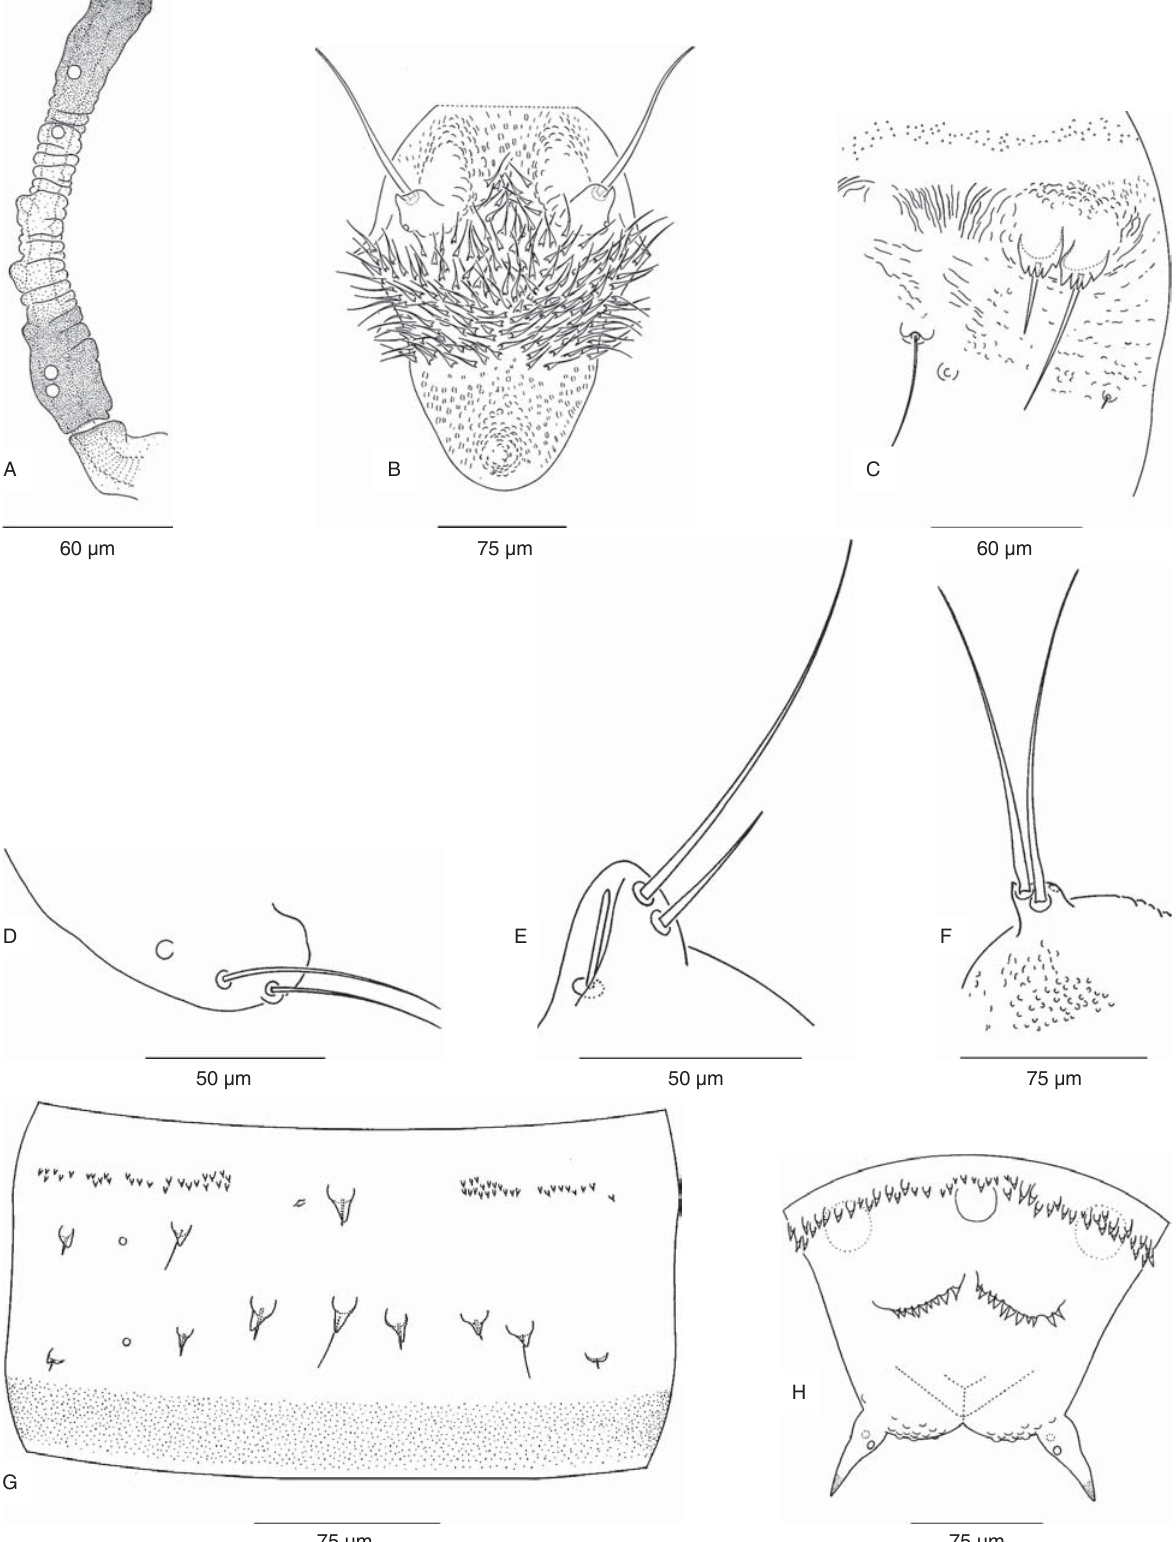
FIG. 3 The pupa of Culicoides tuttifrutti : (A) prothoracic respiratory horn; (B) ♀ operculum; (C) thorax; (D) ventrolateral setae (vl); (E) dorsolateral tubercle (dl); (F) anterodorsal tubercle (ad); (G) fourth abdominal segment; (H) caudal